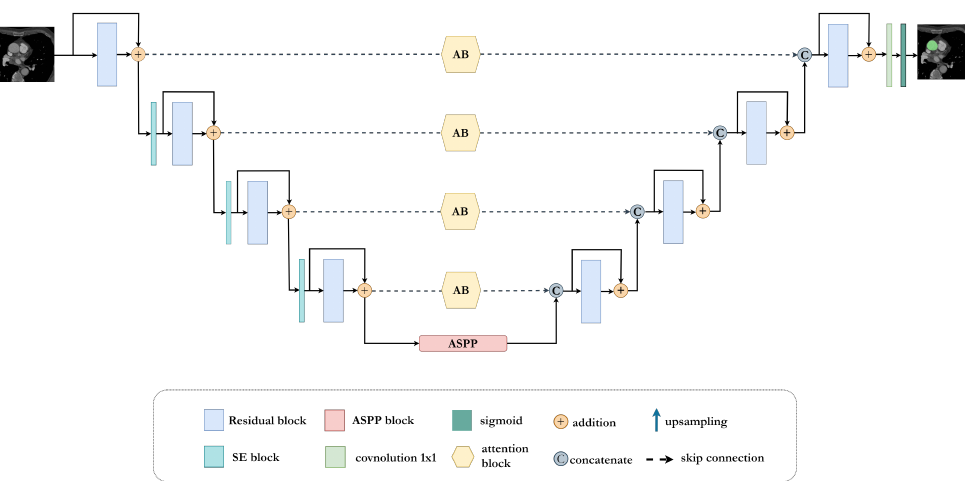
Figure 1. An illustration of the proposed AB-ResUNet+ architecture. The encoder consists of squeeze- and-excitation and residual blocks, while the decoder includes only residual blocks. The channel attention block is inserted into the skip connection to optimize the coding ability of each layer. The ASPP block is placed at the bottom of the network and acts as a bridge between the encoder and